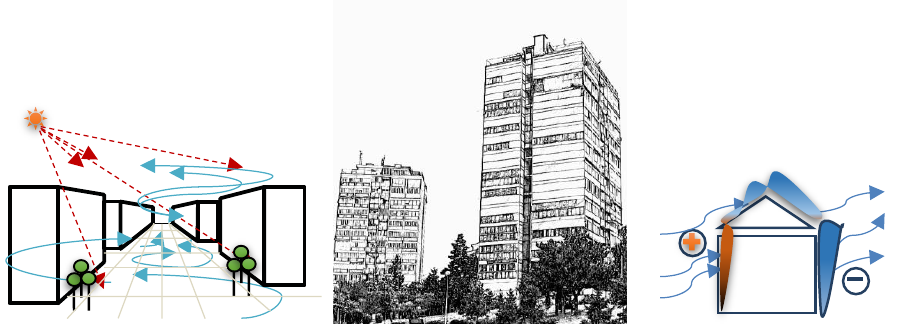
Fig. 2. Skyscraper’s Ulpiana, analysed a conceptual housing unit, wind pressure-cross